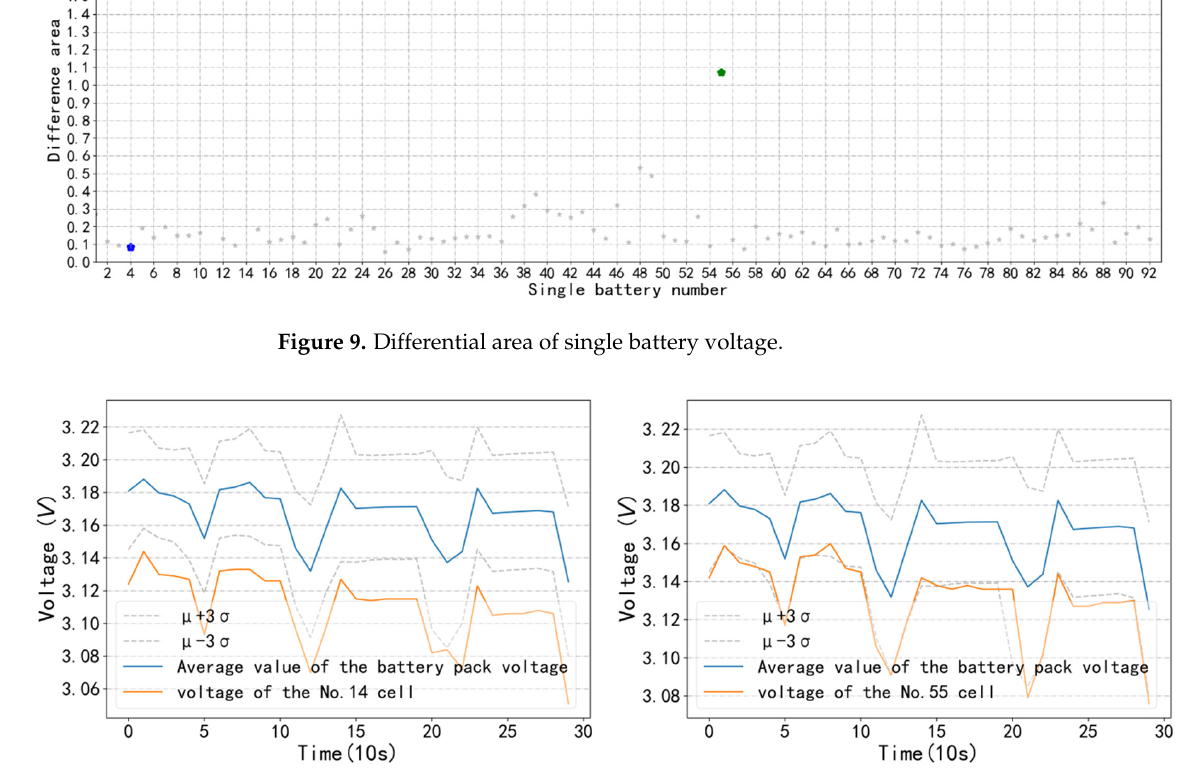
Figure 10. Graph of the voltage of single batteries over time.